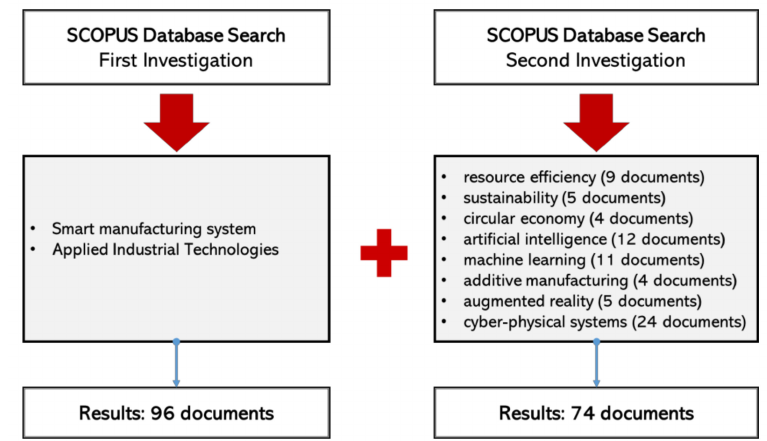
Figure 2. Scheme of the query and related results.